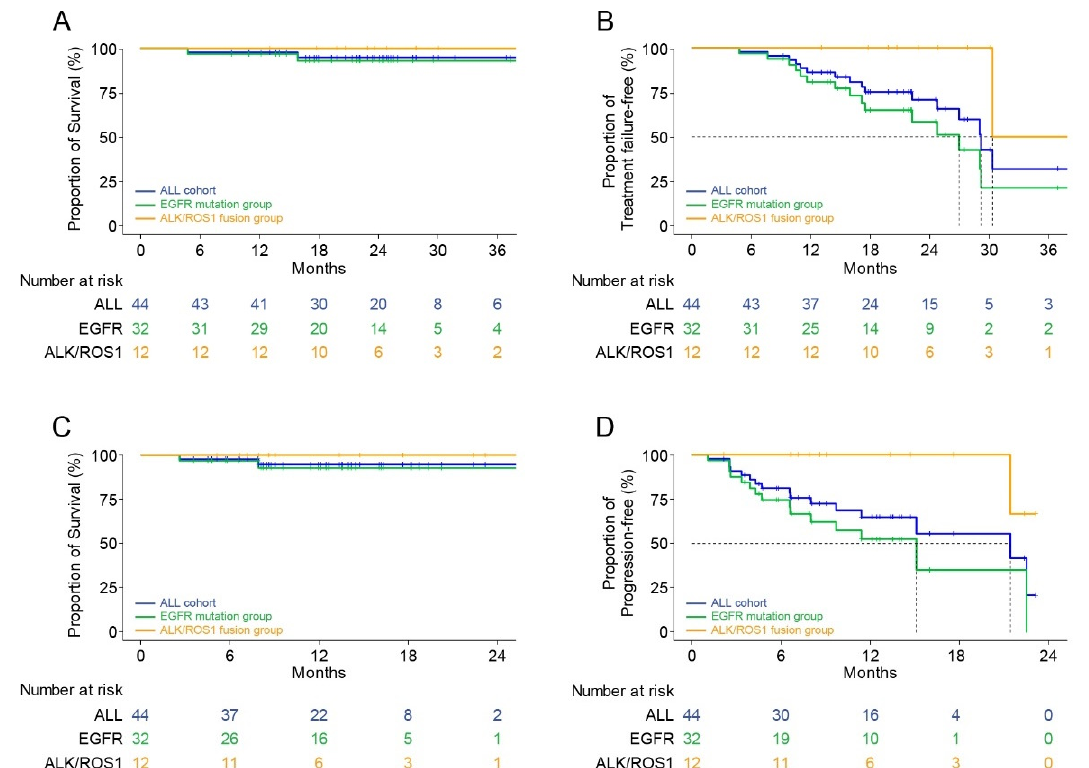
Figure 4. Kaplan–Meier survival curves according to the mutation. ( A ) Overall survival after using the targeted agent immediately before surgery. ( B ) Treatment failure-free survival after using the targeted agent immediately before surgery. ( C ) Overall survival after surgery. ( D ) Progression-free survival after surgery.